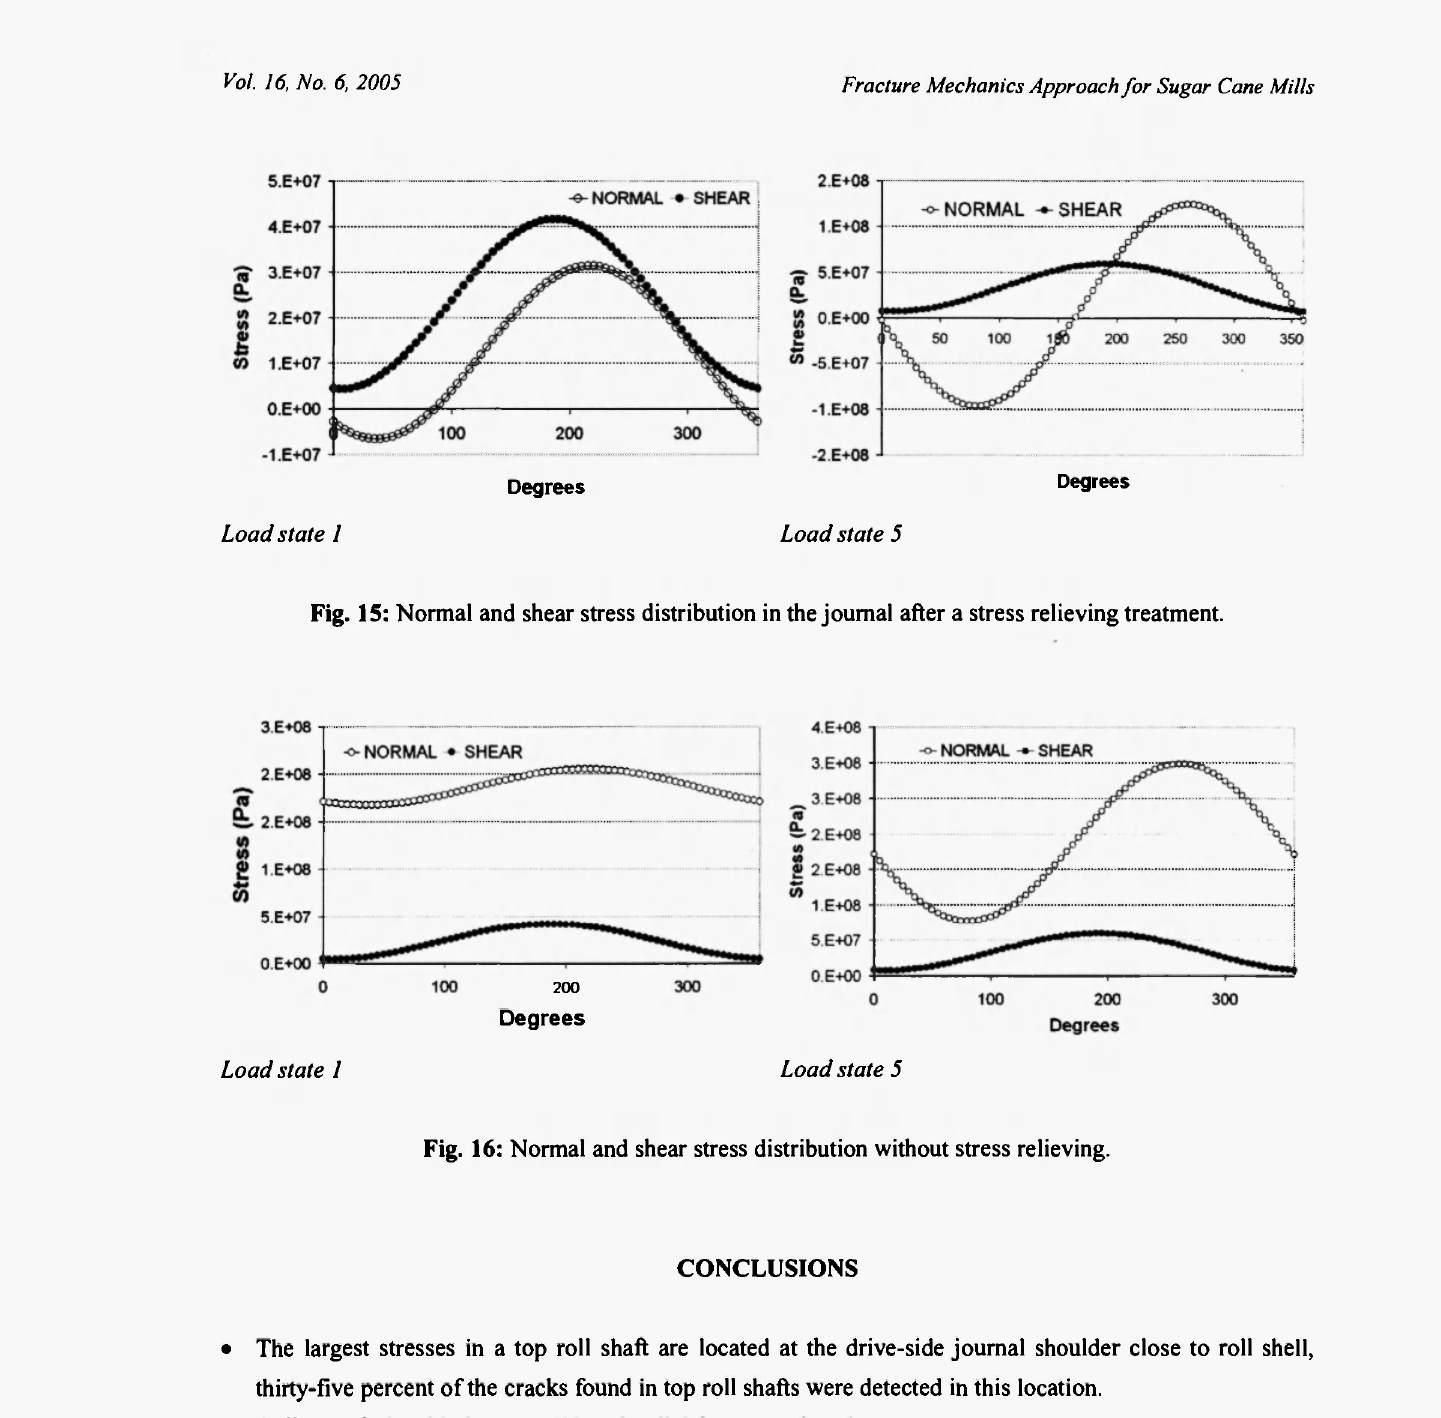
Fig. 16: Normal and shear stress distribution without stress